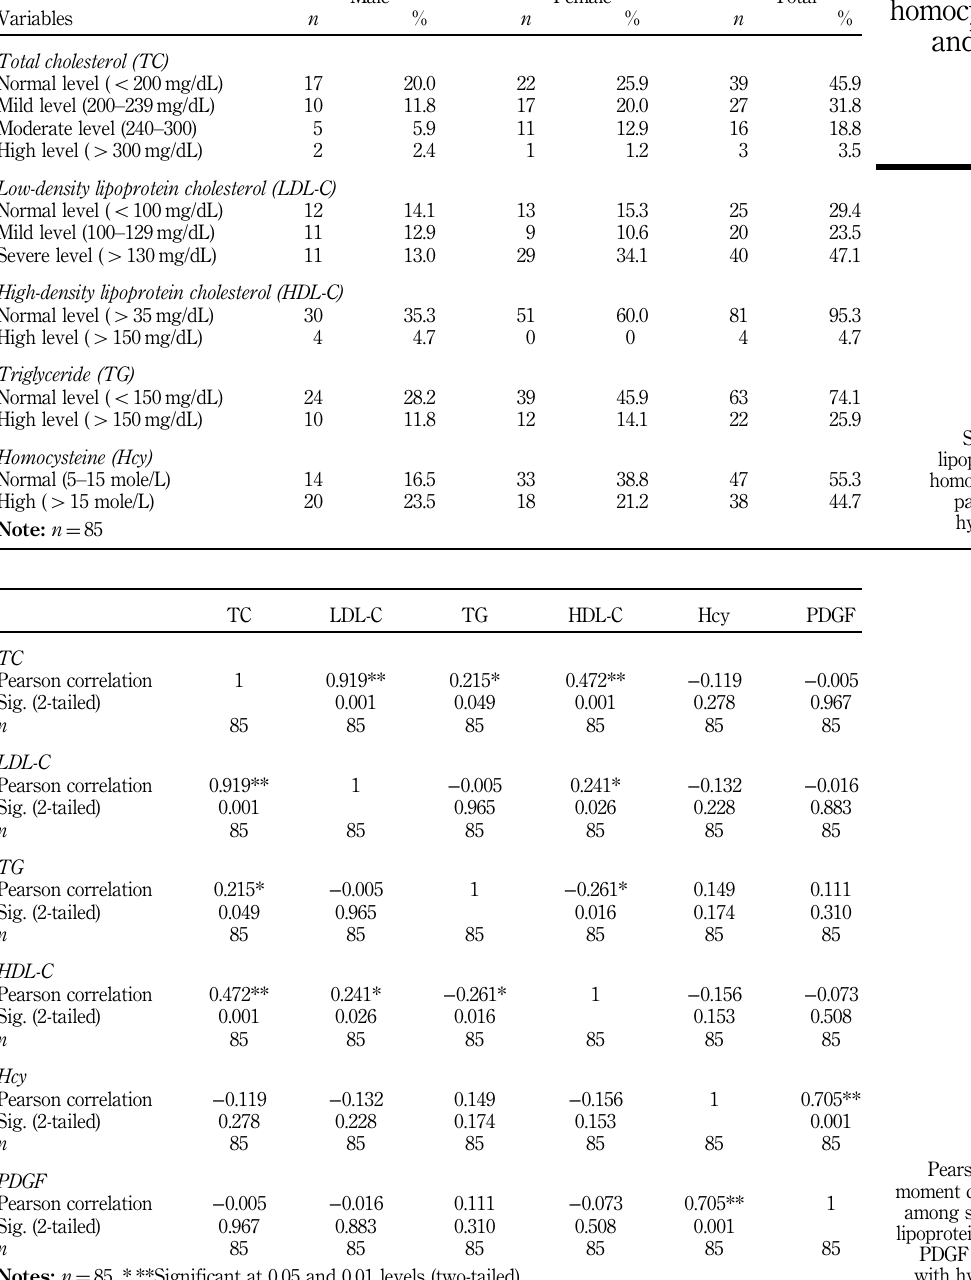
Table III. Pearson product moment correlations among serum lipid, lipoprotein, Hcy and PDGF in